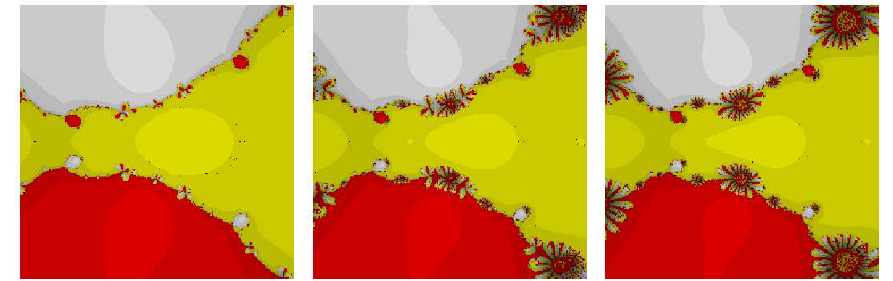
Figure 2. The methods M 1 , M 2 and M 3 , respectively for test problem 2.